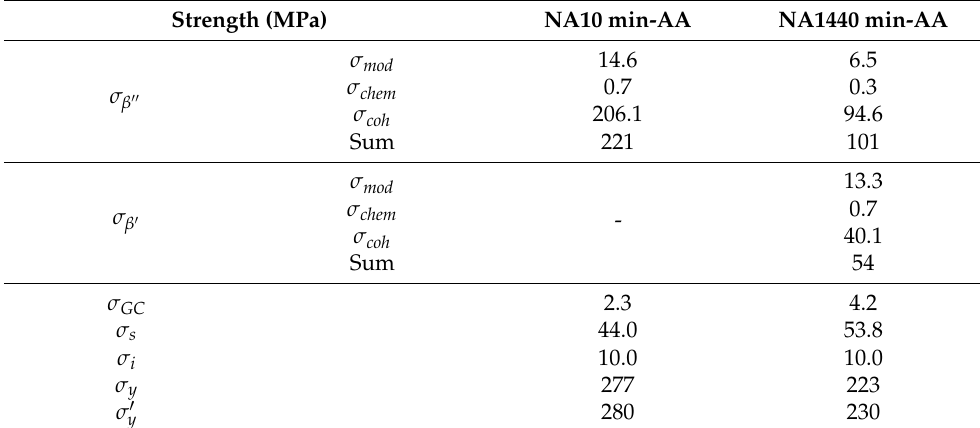
Table 2. The calculation results of the various contributions of